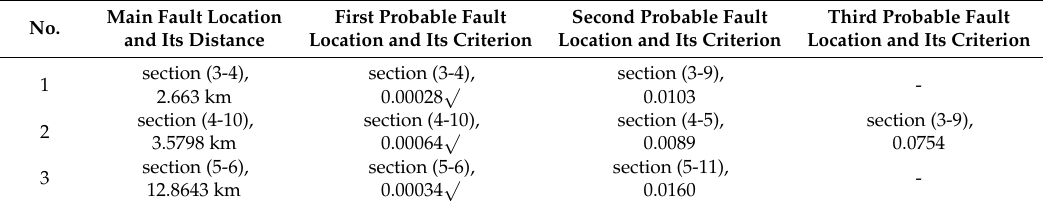
Table 4. Determining the main fault section in different distances with fault resistance of 150